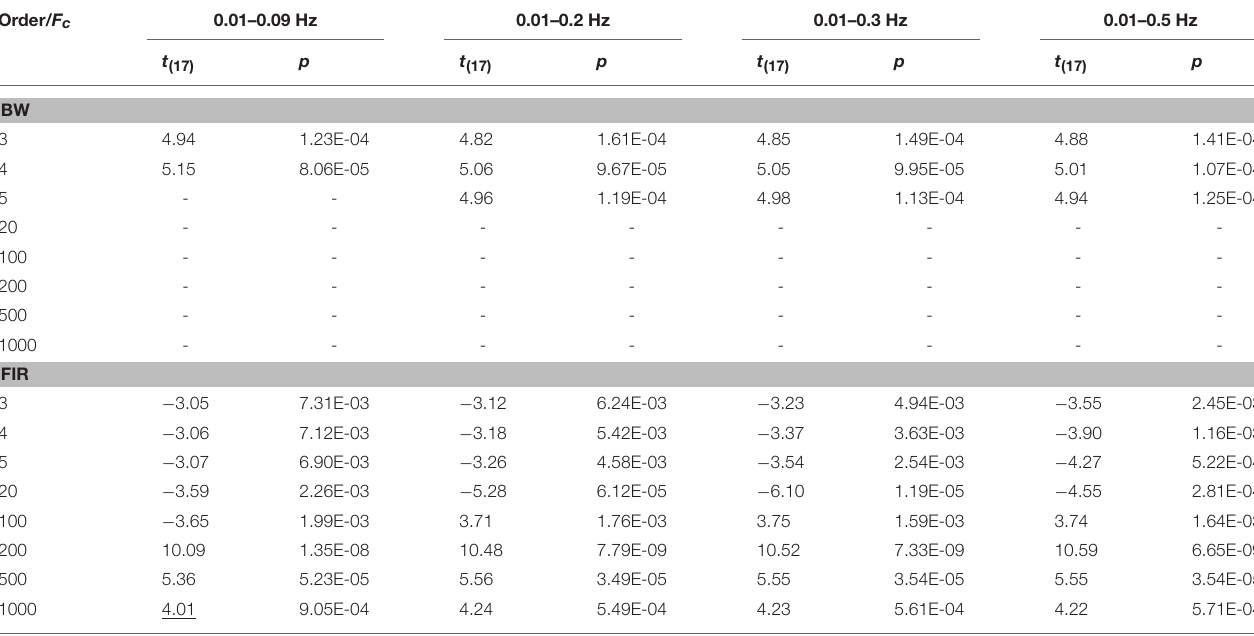
TABLE 7 | One sample t -test results computed on 1 HbR C BP filtered data, with Amplitude 1, comparing the group median β -values to the reference β , in case of precoloring correction. Order/ F